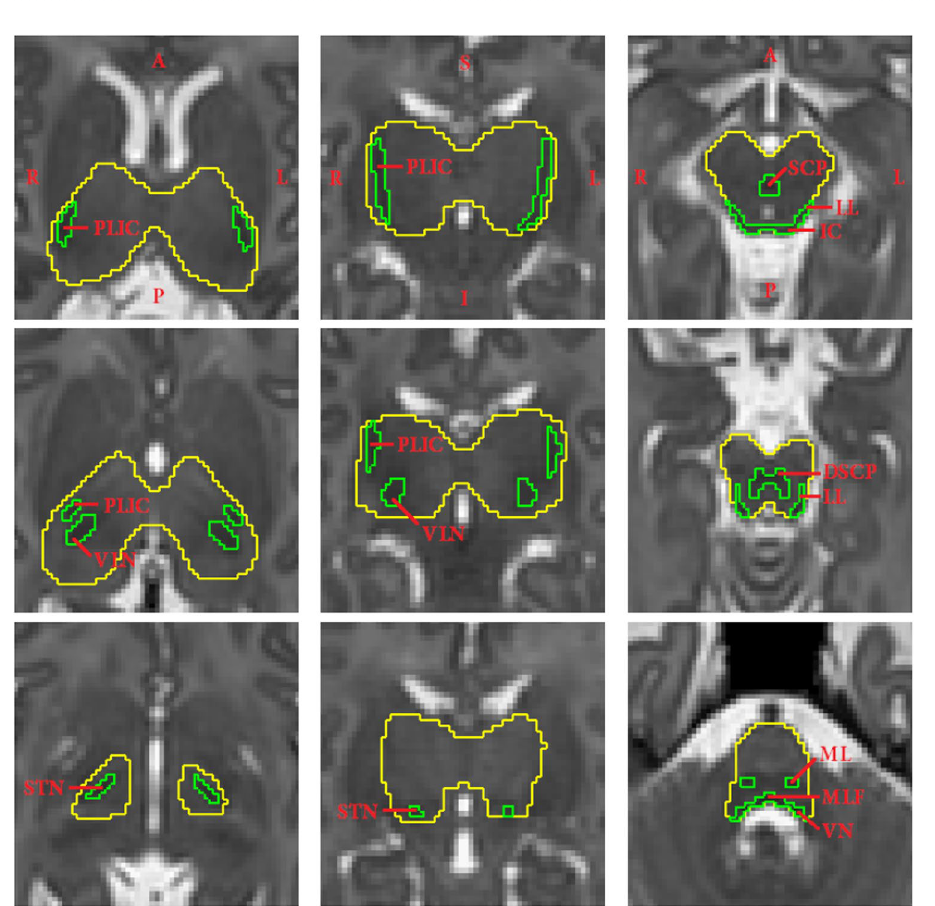
Figure 4. Manual annotations of myelin-like signals (green label) in the deep brain region and brainstem of a subject at 42 gestational weeks, delineated according to the defined segmentation protocol. The regions of interest are labeled in yellow. The columns from left to right show the deep brain region in the axial and coronal views, and the brainstem in the axial view. Abbreviations: PLIC–posterior limb of the internal capsule, VLN– ventrolateral nucleus, STN–subthalamic nucleus, SCP–superior cerebellar peduncle, DSCP–decussation of the superior cerebellar peduncle, IC–inferior colliculus, LL–lateral lemniscus, ML–medial lemniscus, MLF–medial longitudinal fasciculus, VN–vestibular